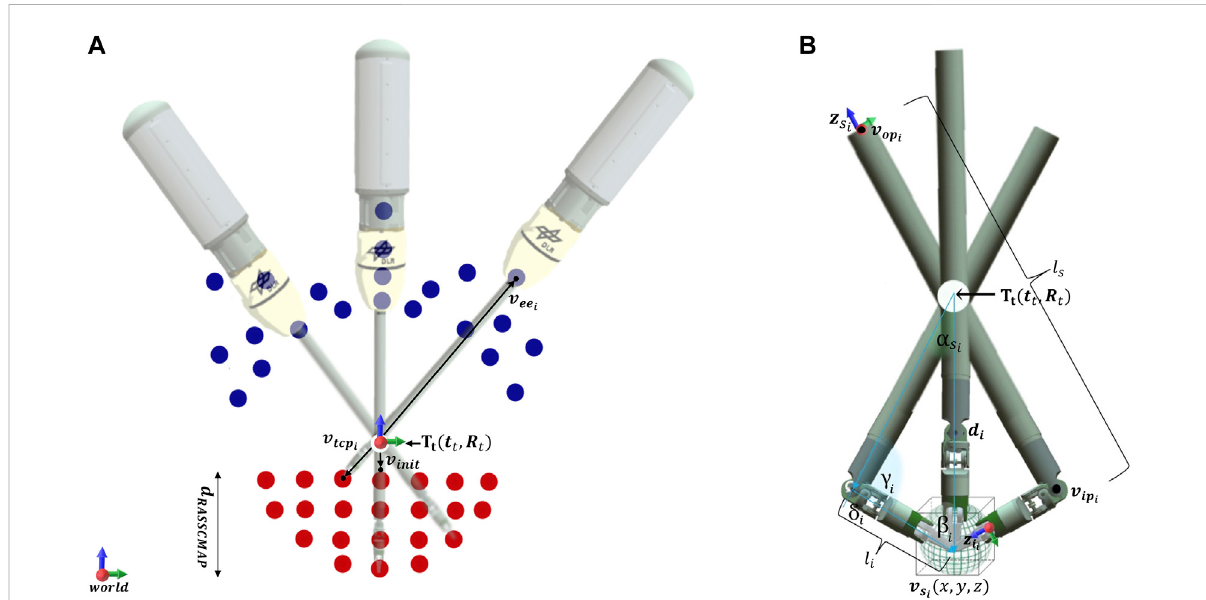
FIGURE 6 Computation of the RASSCMAP. (A) Three iterations of RASSCMAP shape generation process showing different instrument penetration depths and rotations around the entry access point ( T t ). (B) Three iterations of RASSCMAP enhancement with instrument rotation around voxel pivot point ( v s i